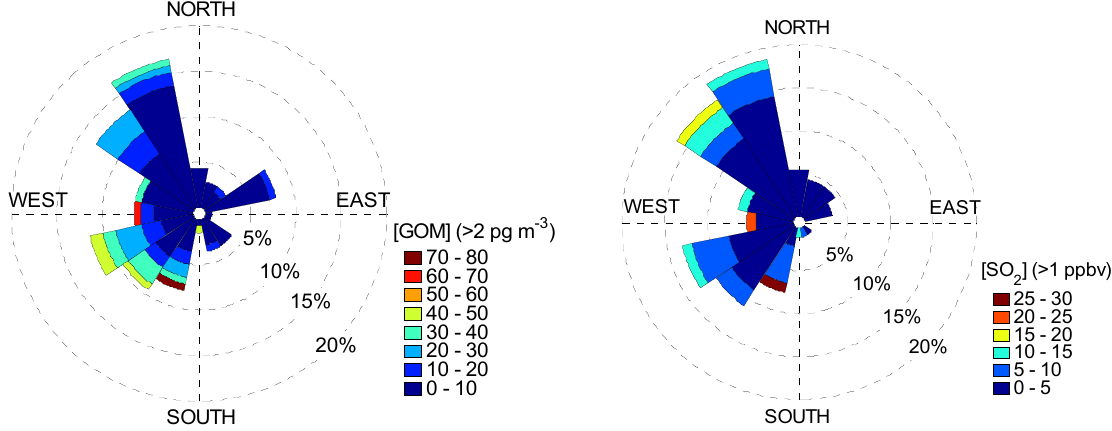
Figure 7. Wind rose plots for GOM with [GOM] > 2 pg·m − 3 ( Left ) and SO ppbv ( Right ) during the summer 2010